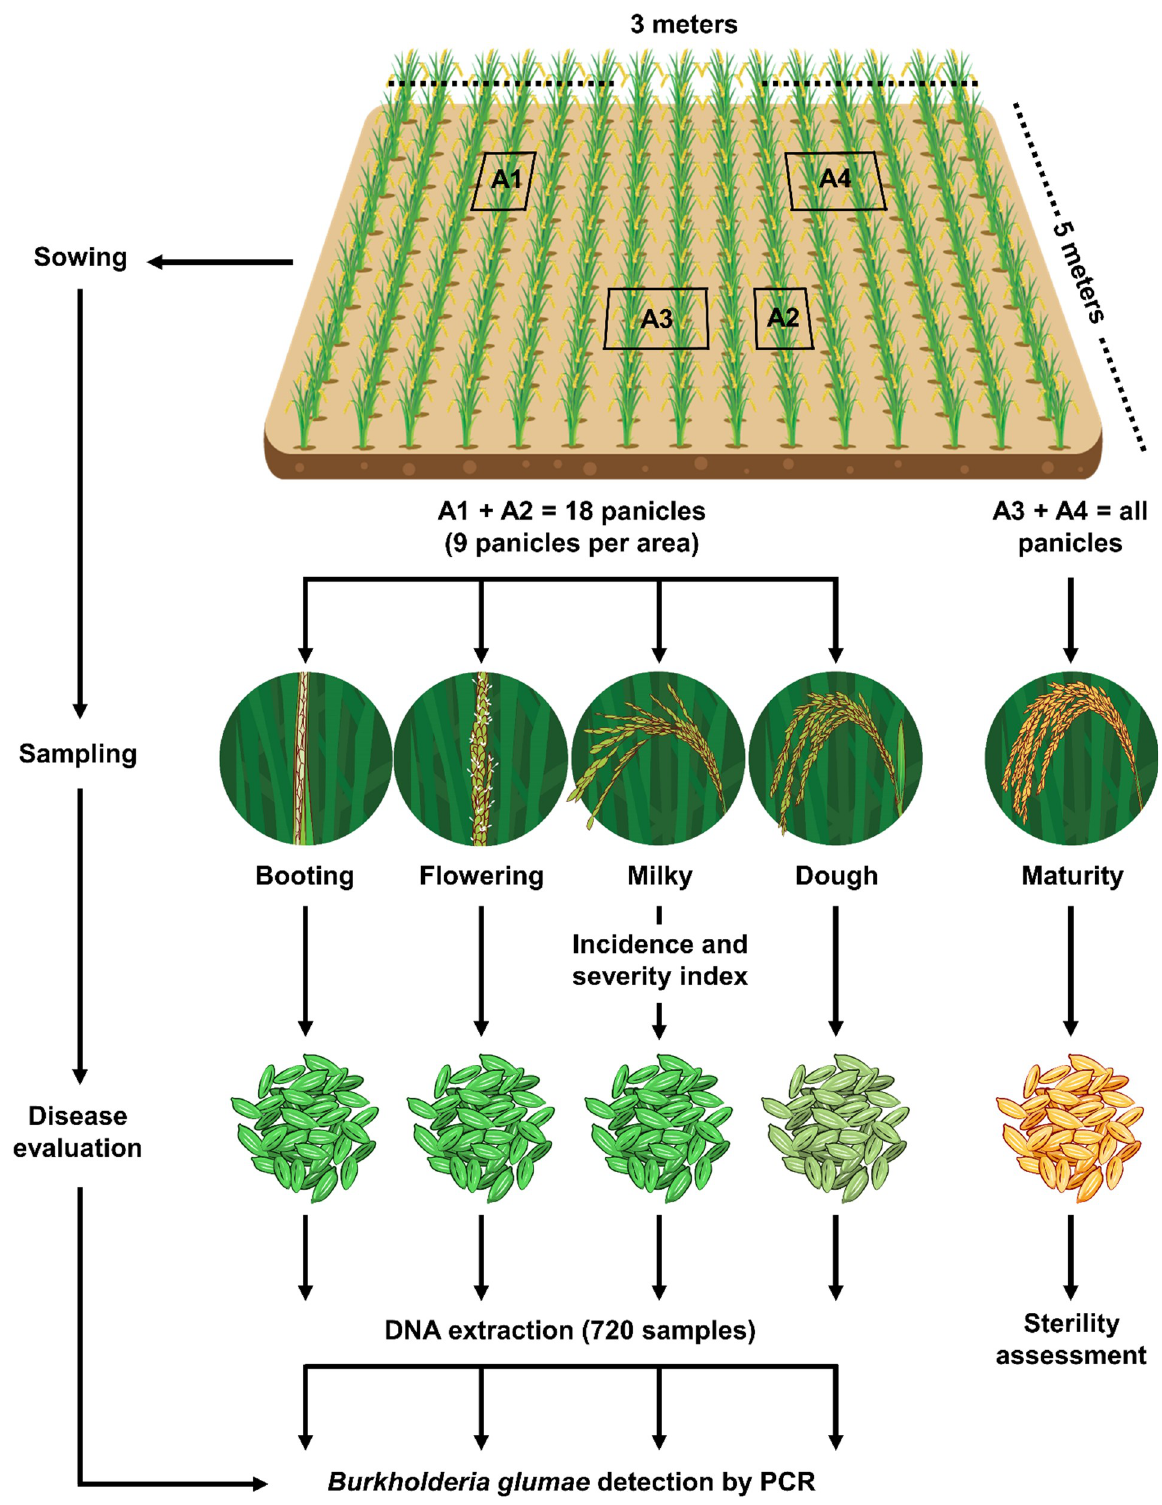
Fig 1. Experimental design used for field trials. Plot size and sampling strategy to measure disease parameters (A1 and A2, 0.05 m 2 ) and sterility (A3 and A4, 0.2 m 2 ).